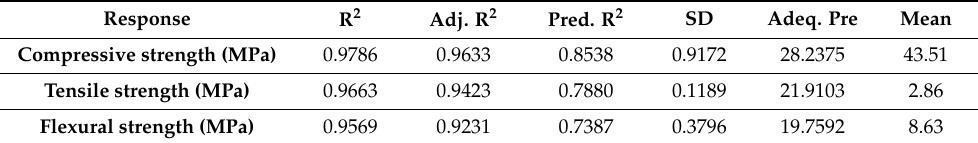
Table 9. Validation of model terms for responses.